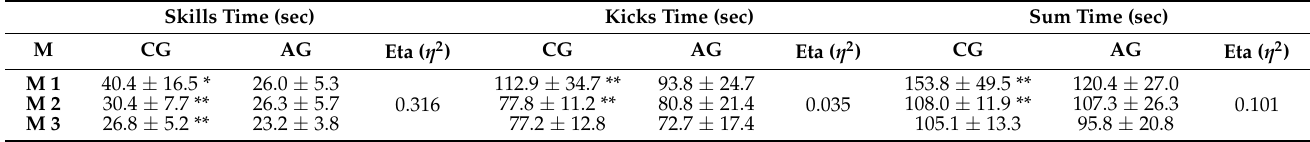
M = Measurement, M 1 = Measurement 1, M 2 = Measurement 2, M 3 = Measurement 3, CG = Control Group, AG = Alter- native Group, * = Statistically significant difference between groups, ** = Statistically significant difference between meas- urements.